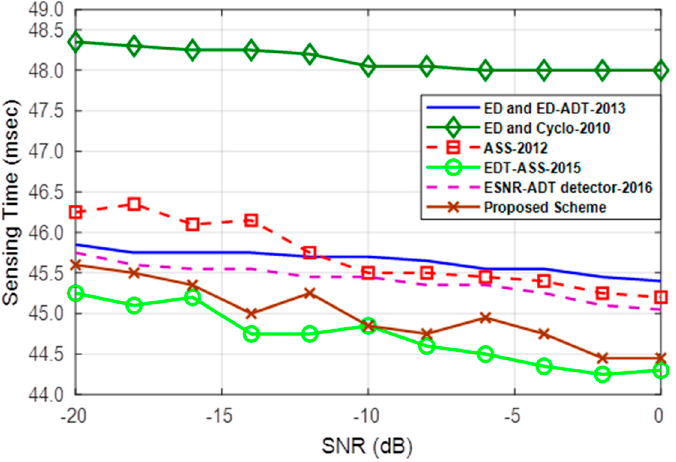
Figure 8. Sensing time versus SNR values.